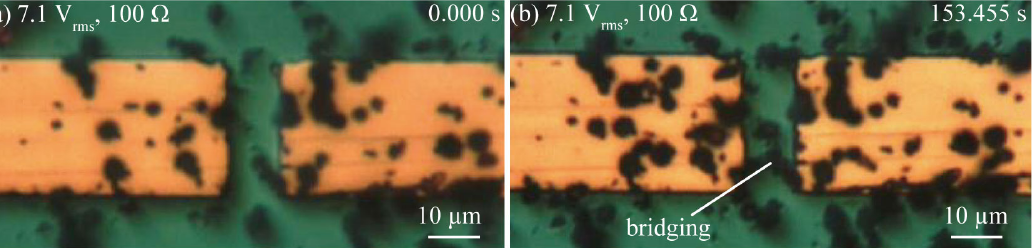
Figure 4. Series of optical images showing copper microparticle chain formation in the case of a low voltage (7.1 V rms , 100 Ω ). ( a ) The beginning of the application of voltage to the gap. ( b ) Microparticles being trapped in the gap, thereby bridging the gap.